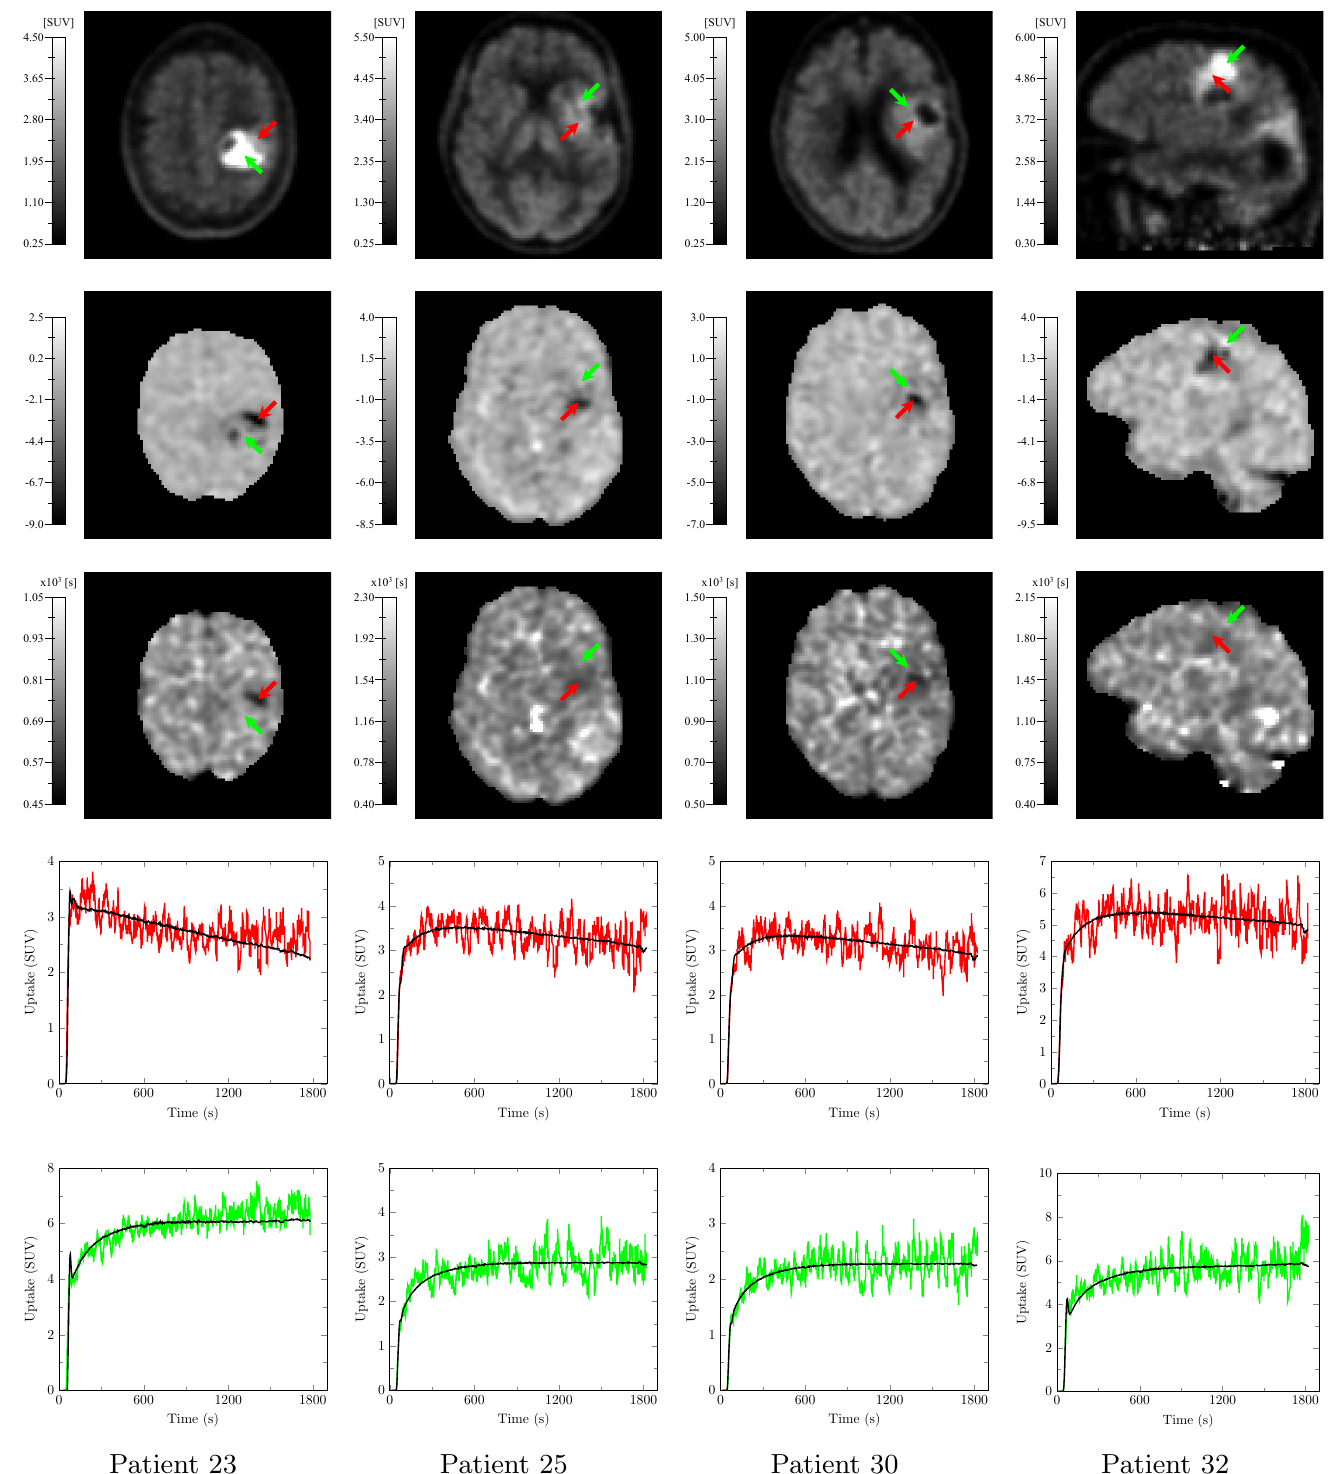
Figure 8. Static PET image (20–27 min p.i.—1st row) and PC3 (2nd row) and 1/ k 2 (3rd row) maps computed from the dynamic [ 11 C]MET PET scans of four evaluation patients (patients 23, 25, 30, and 32 in Table A1) along with the smoothed TACs at voxels pointed by the red (4th row) and green (5th row) arrows, respectively. Red TACs have a ‘decreasing’ or ‘flat’ behavior whereas green TACs have a ‘flat’ or ‘increasing’ behavior. TAC reconstruction with 4 of the 5 principal components (PC1–3 and 5) is superimposed in black to each